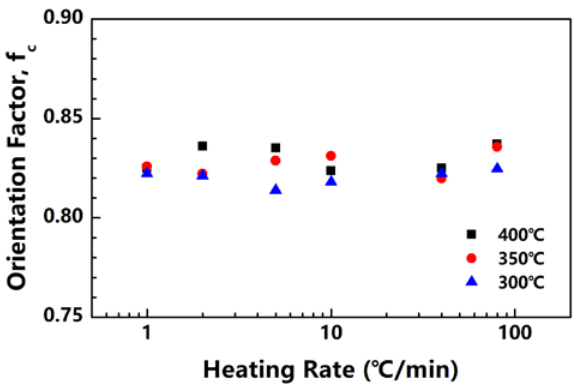
Figure 6. Crystal orientation factors of PI fibers obtained under different heating rates.